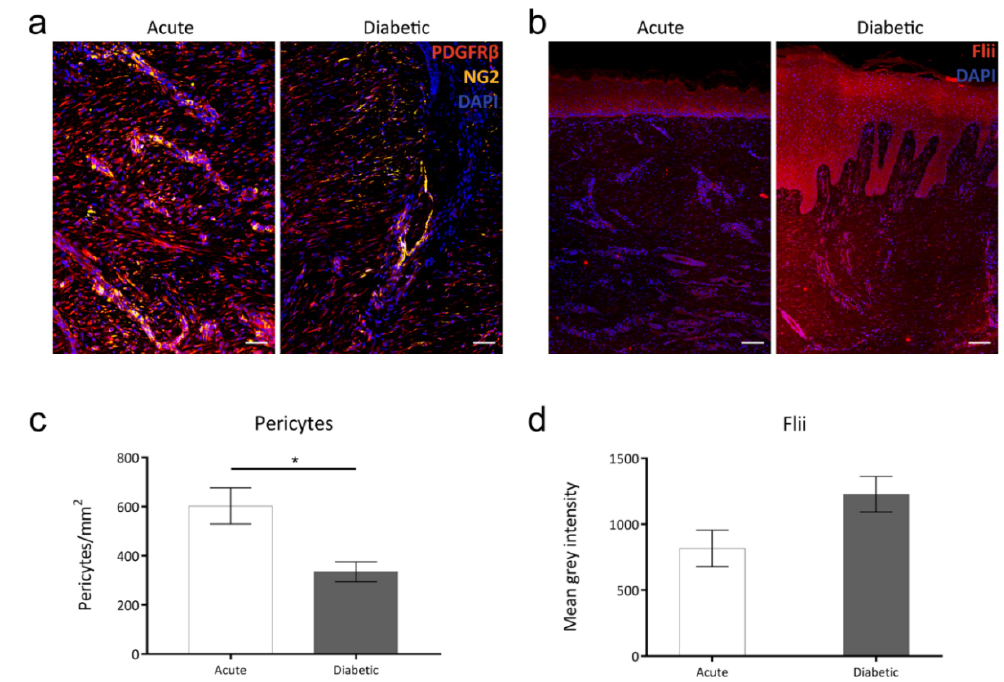
Figure 1. ( a ) Dual Platelet derived growth factor receptor β (PDGFR β ) / neural glial antigen 2 (NG2) pericyte staining in 4 µ m sections of para ffi n-embedded acute and diabetic human wounds, scale bar = 50 µ m. ( b ) Immunohistochemical detection of Flightless I (Flii) in corresponding 4 µ m sections of para ffi n-embedded acute and diabetic human wounds, scale bar = 100 µ m. Composite images captured at 20 × objective. Graphical data of ( c ) the number of pericytes per mm 2 within acute and diabetic human wounds and ( d ) the expression levels of Flii in acute and diabetic human wounds. * = p < 0.05.